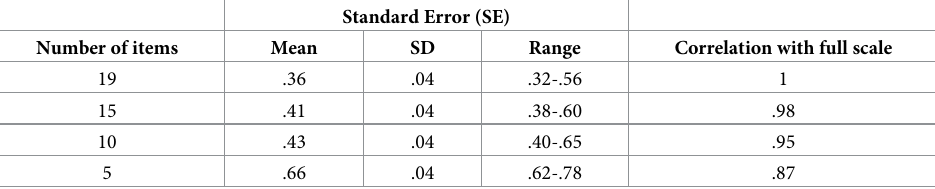
Table 3. Summary of simulated computer adaptive